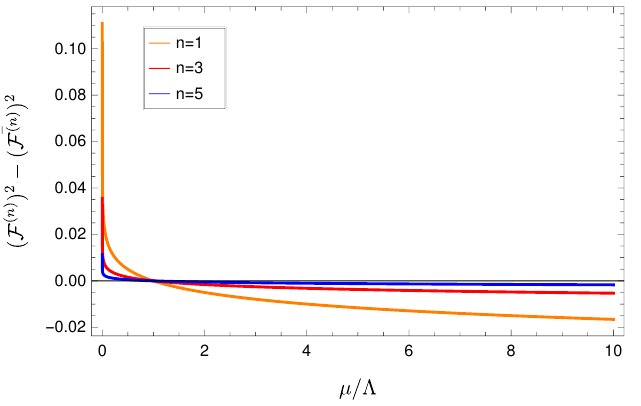
Figure 11 . Plot of the left-hand side of eq. (5.45) as a function of µ , for fixed g = 0 . 8 , m = 1 and various choices of n